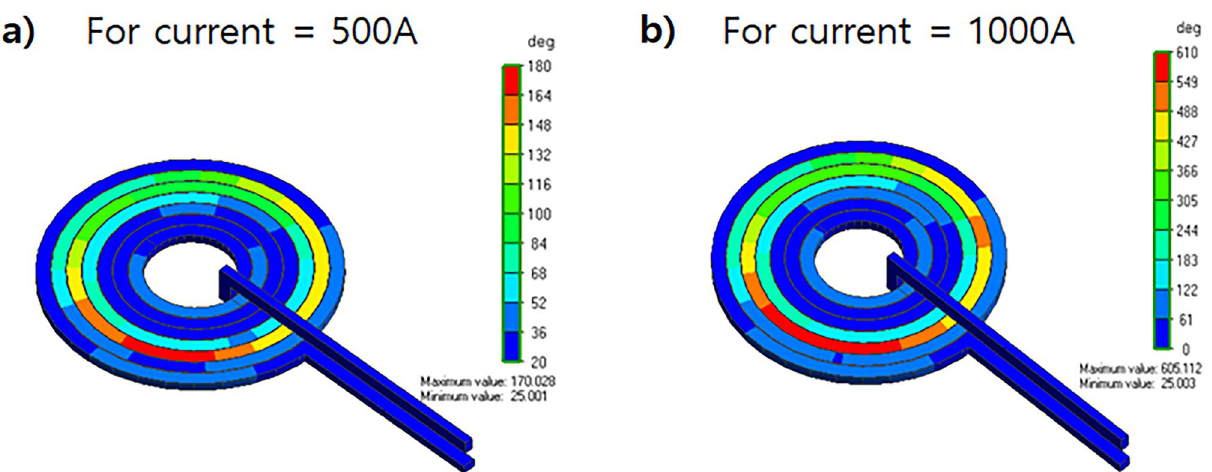
Figure 14. Thermal distribution of coil simulation using different current values: ( a ) 500 A; ( b ) 1000